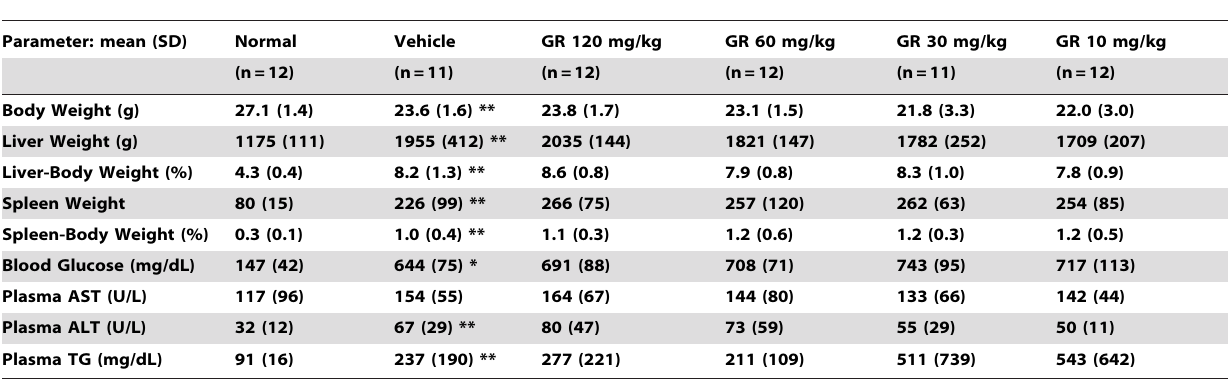
Table 2. Comparison of physical and lab parameters between animal groups in dose response experiment with GR-MD-02 (GR).